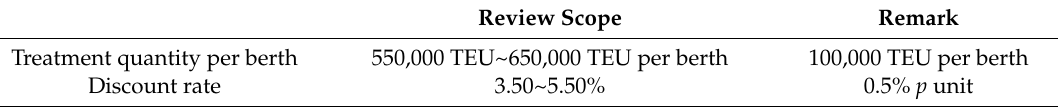
Table 2. Sensitivity analysis